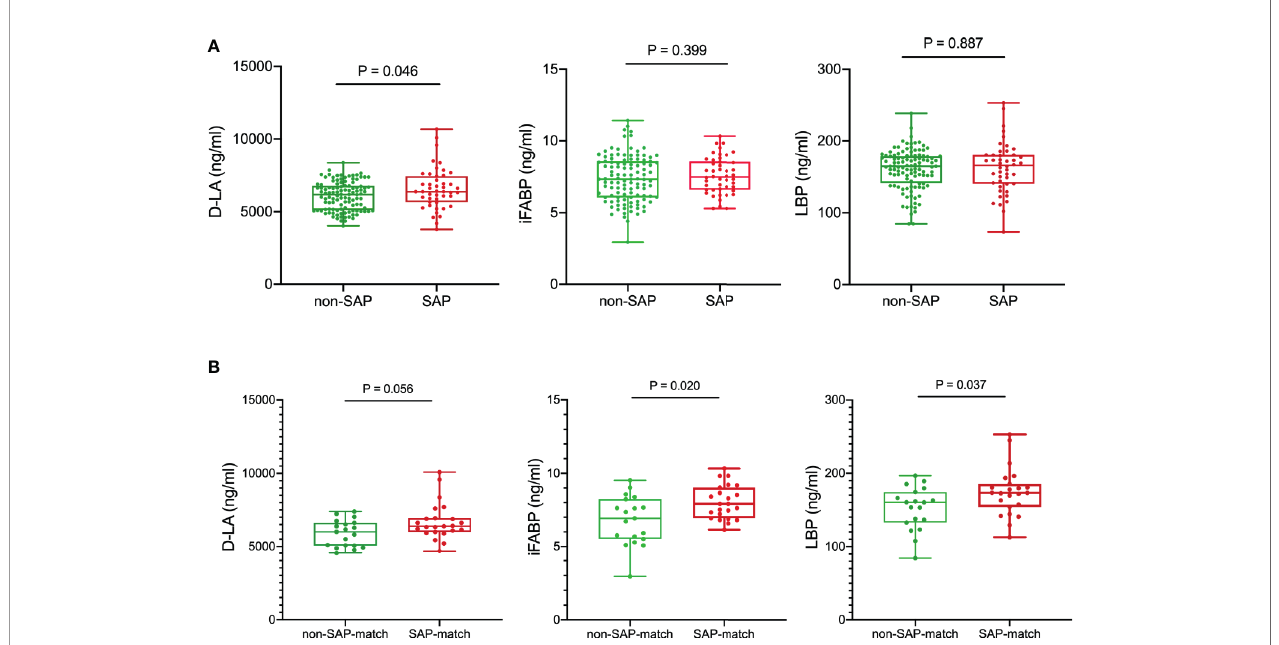
FIGURE 5 | Comparison of serum intestinal integrity biomarkers between patients with SAP and without SAP in the training cohort (A) and age-, NIHSS- and dysphagia- matched subset (B) of the training cohort. Patients with SAP had increased serum D-LA, iFABP and LBP levels at the early acute stage than patients without SAP. Mann-Whitney U test. D-LA, D-lactate; iFABP, intestinal fatty acid-binding protein; LBP, lipopolysaccharide-binding